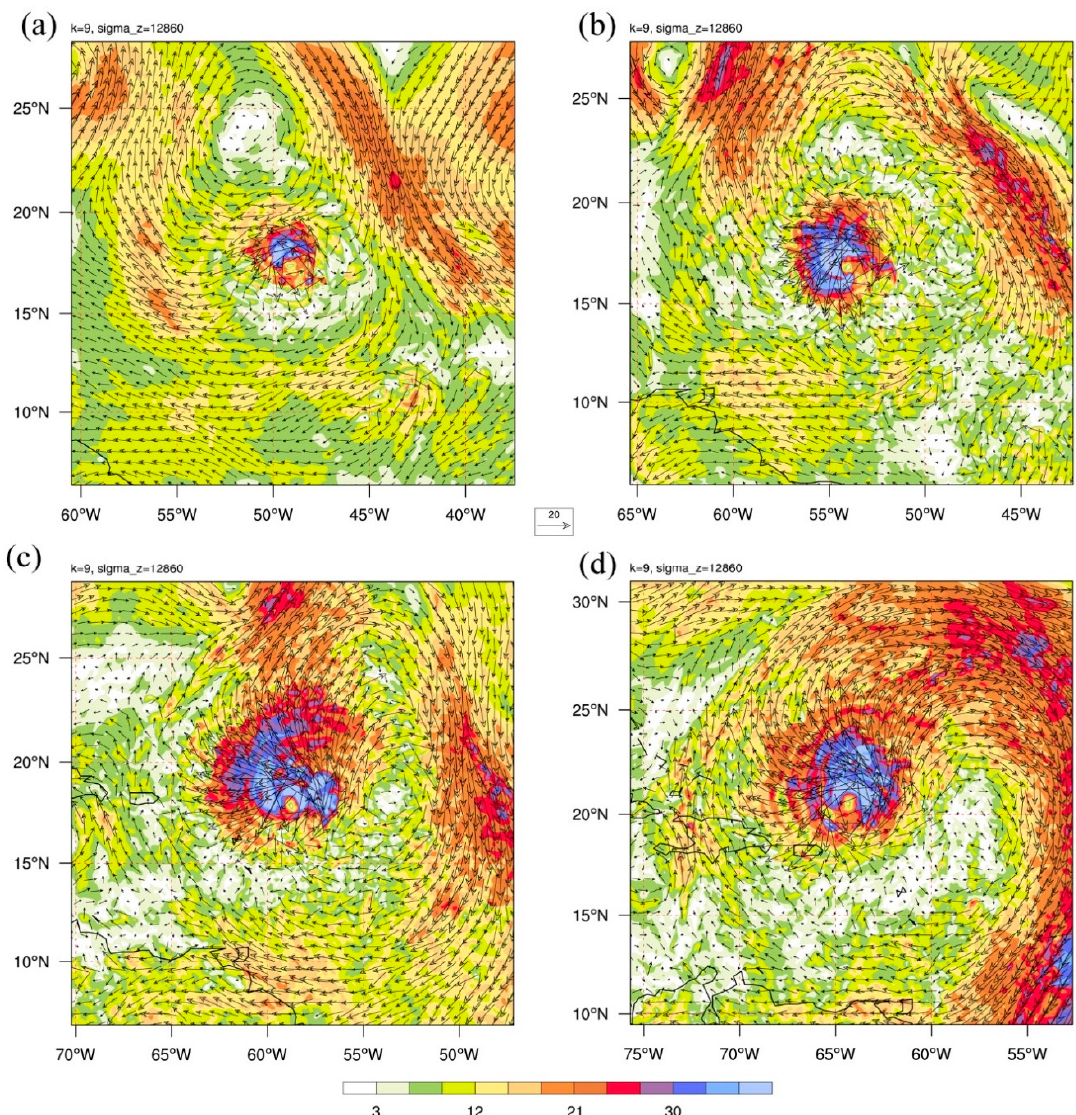
Figure 13. As in Figure 11, except from ( a ) warm-start initial conditions from the CIMSS hourly AMV FCDI analysis as in Figure S1 panel (d), and then COAMPS-TC forecasts at ( b ) tau + 24 h, ( c ) tau + 48 h, and ( d ) tau + 72 h.